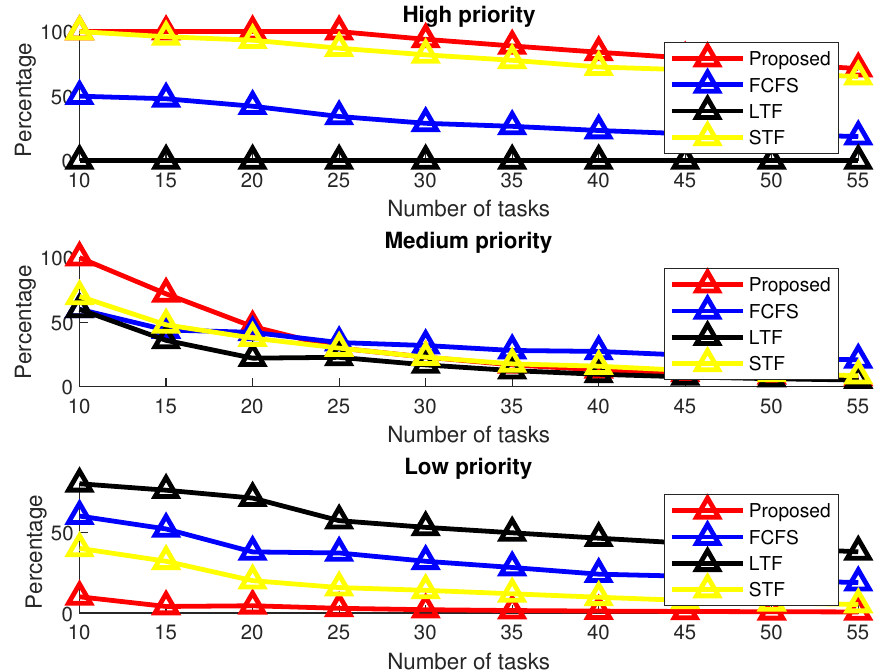
Figure 6. Percentage of tasks performed by fog nodes for varying number of tasks.